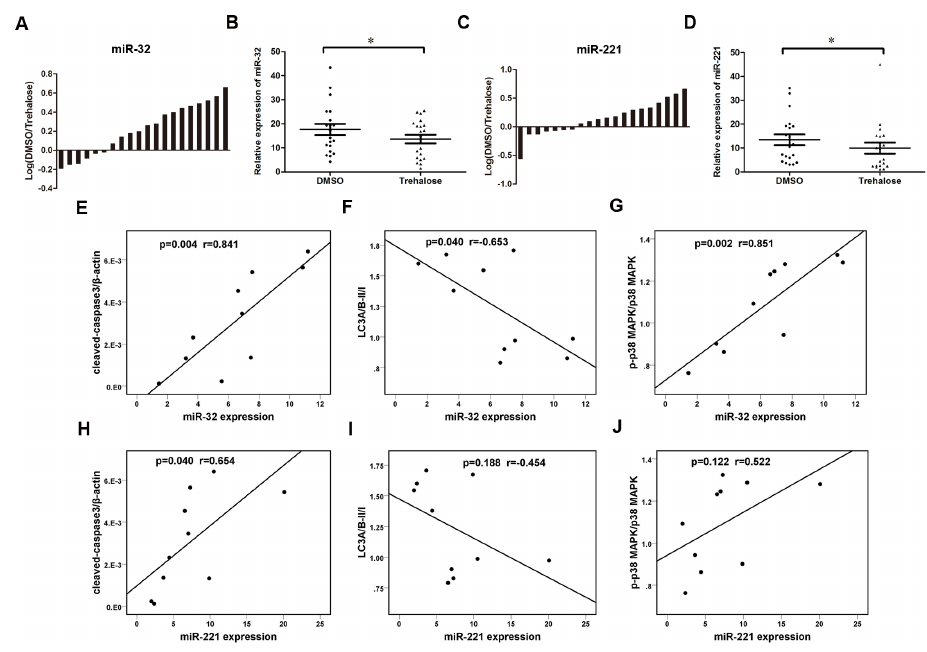
Fig 5. Expression levels of miR-32 and miR-221 in cryopreserved valve cells. Twenty pairs of DMSO samples and trehalose samples were analyzed by qRT-PCR and normalized to U6 expression. (A and C) The bars represented relative miR-32 and miR-221 expression with the ratio of levels in DMSO samples to those in trehalose samples on a logarithmic scale. (B and D): miR-32 and miR-221 expression levels in DMSO samples and trehalose samples were compared with a paired Student’s t-test. (cid:3) P < 0.05 versus DMSO group. (E, F and G): correlation analysis between miR-32 expression and cleaved caspase-3 level, LC3A/B II/I ratio and p38 MAPK phosphorylation. (H and J): correlation analysis between miR-221 expression and cleaved caspase-3 level, LC3A/B-II/I ratio and p38 MAPK phosphorylation. Spearman’s analysis was used in the correlation analysis.